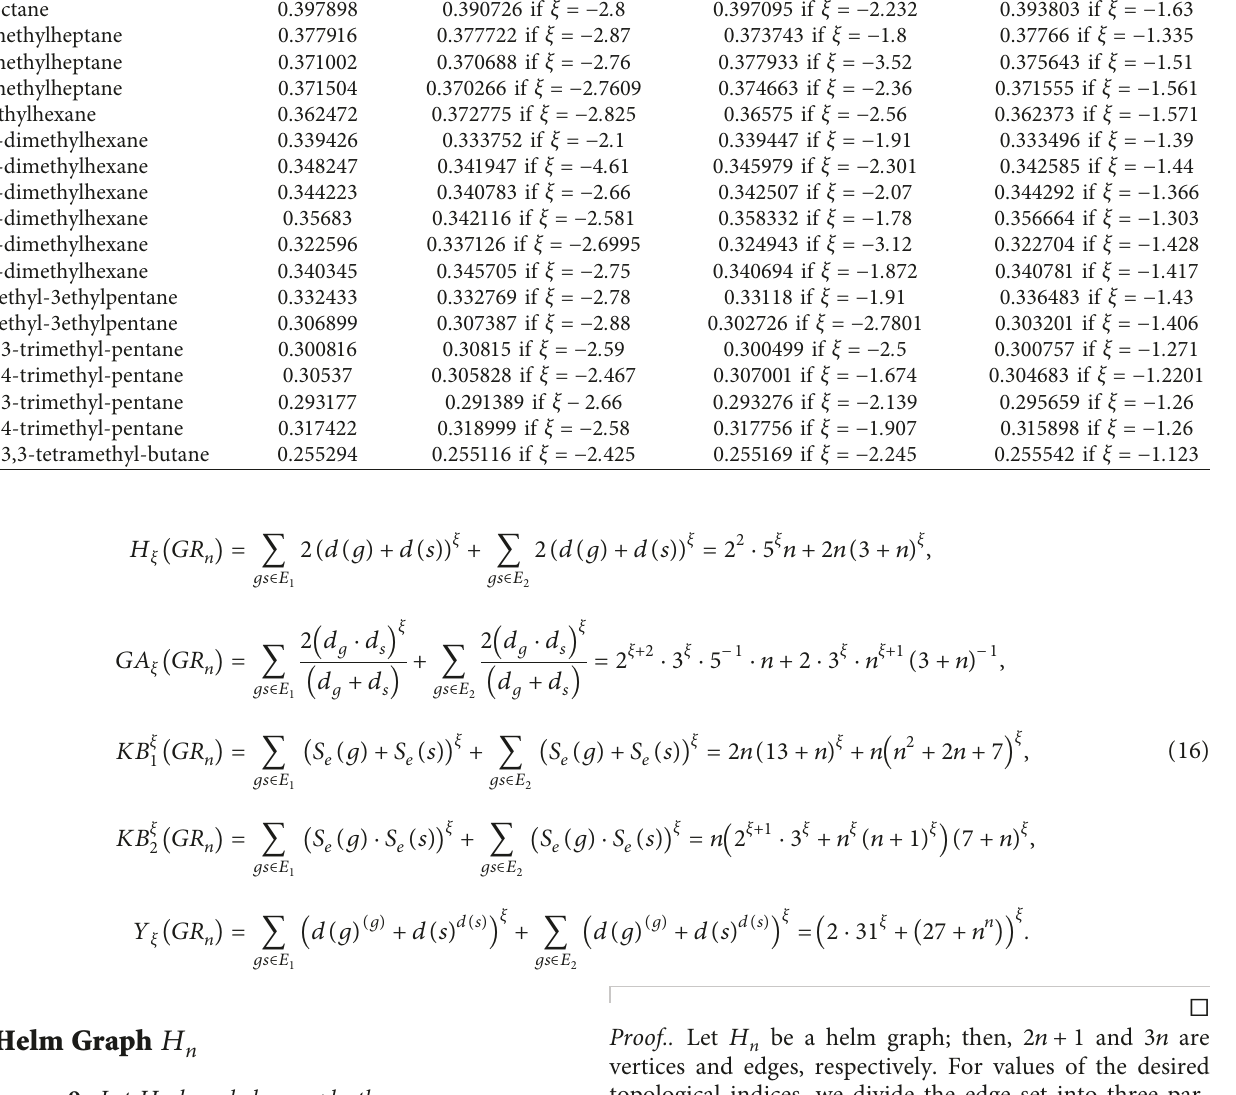
Table 4: Experimental values of acentric factor and the corresponding values of generalized form of harmonic index, geometric arithmetic index, and first Kulli–Basava index of octane isomers for different values of ξ .